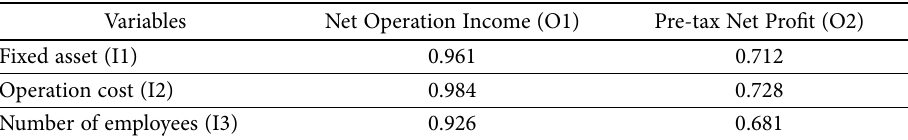
Table 3. Input and output correlation